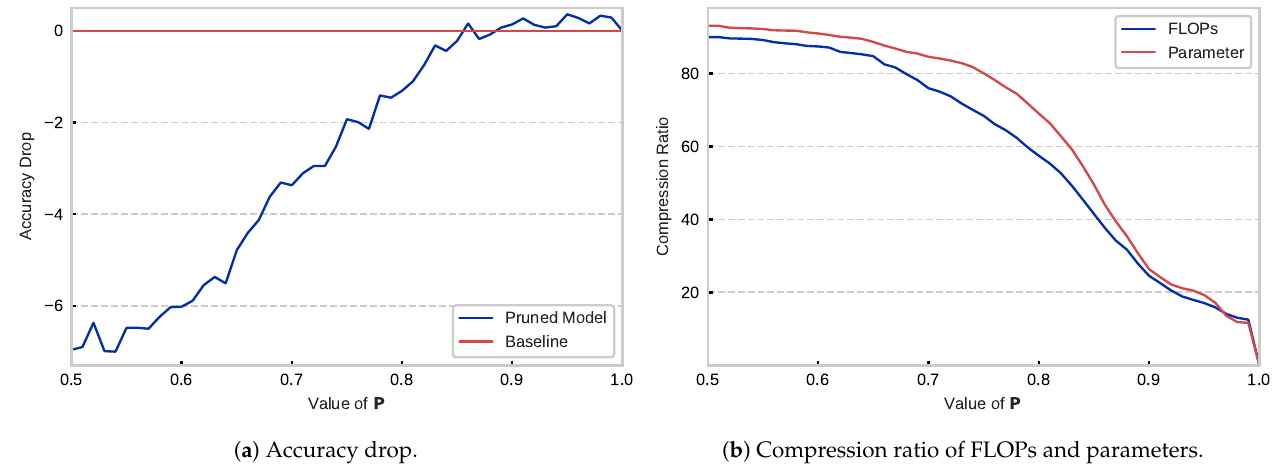
Figure 3. Experimental results of pruning based on a P from 0.5 to